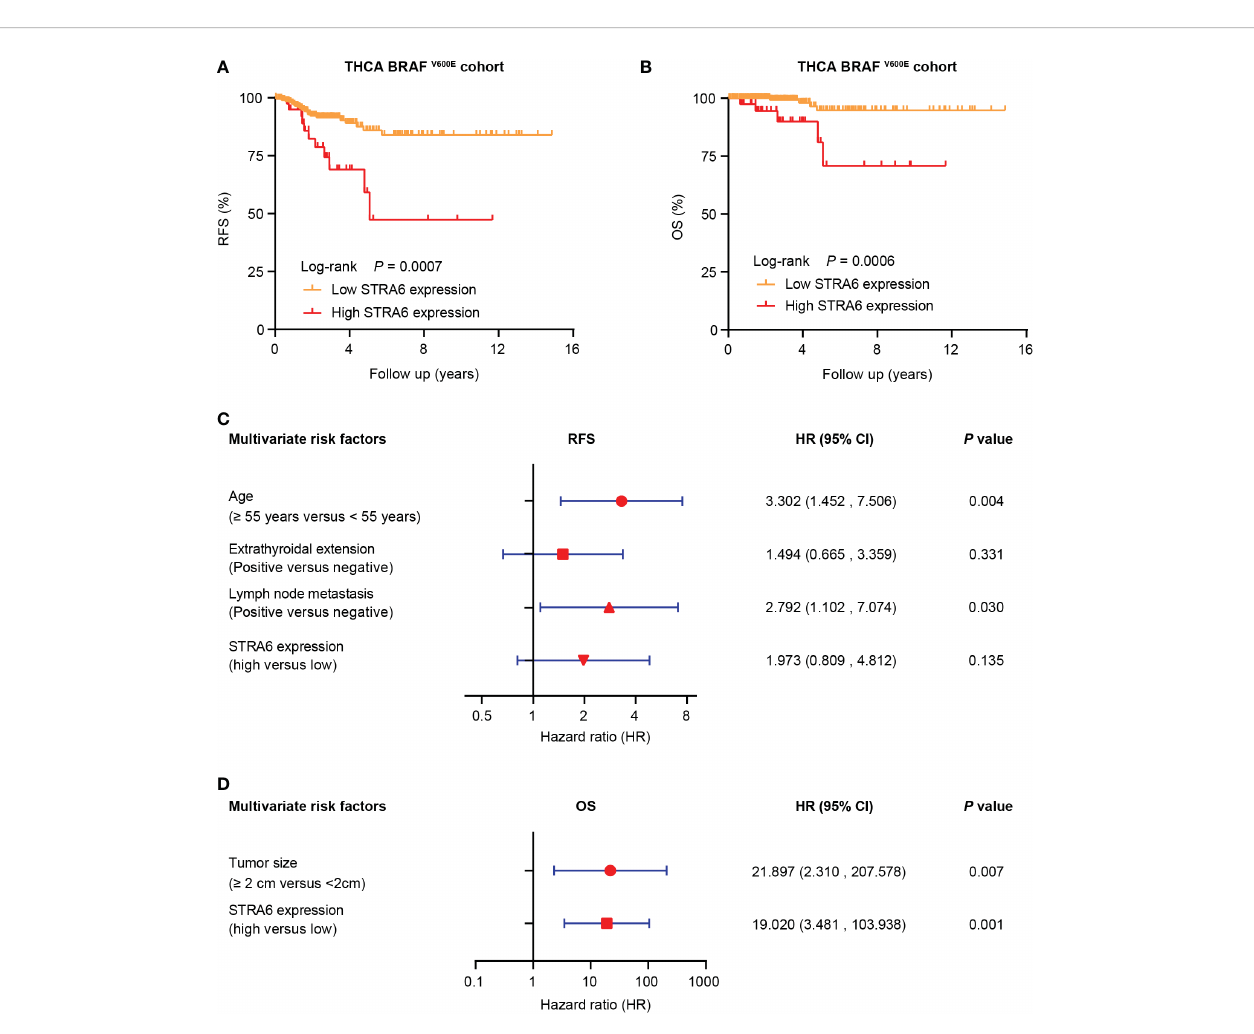
FIGURE 2 STRA6 predicts poor prognosis for BRAF-mutant PTC. (A) Kaplan – Meier survival curves of recurrence-fee survival (RFS) according to STRA6 expression in BRAF-mutant PTC. Prognostic cutoff value was identi fi ed as 10.3 using X-Tile. (B) Kaplan-Meier analysis of overall survival (OS) based on STRA6 expression in PTC patients with BRAF mutation. (C) Multivariate Cox regression analysis of the risk factors for recurrence in BRAF-mutant PTC. All bars represented 95% con fi dence intervals (95% CI). (D) Multivariate Cox regression analysis of the risk factors for mortality in BRAF-mutant PTC. All bars corresponded to 95%